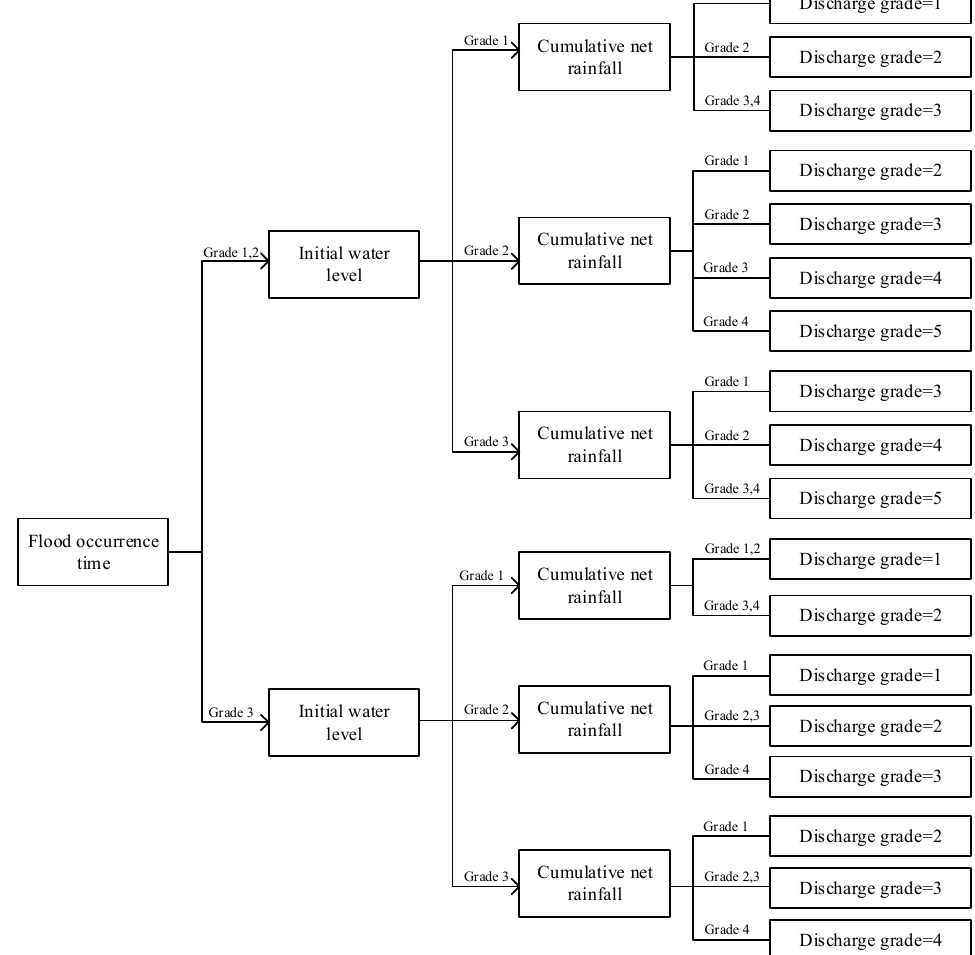
Figure 2. DT-based operation